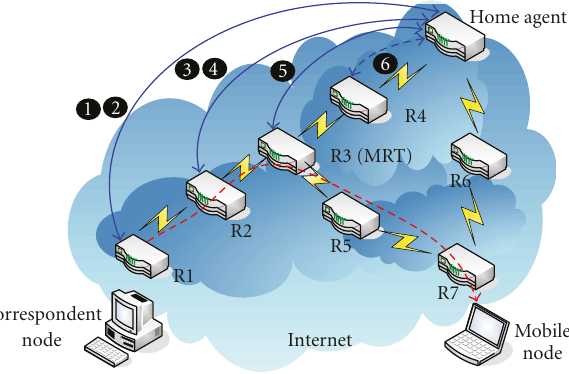
Figure 2: Illustration of backward tracking